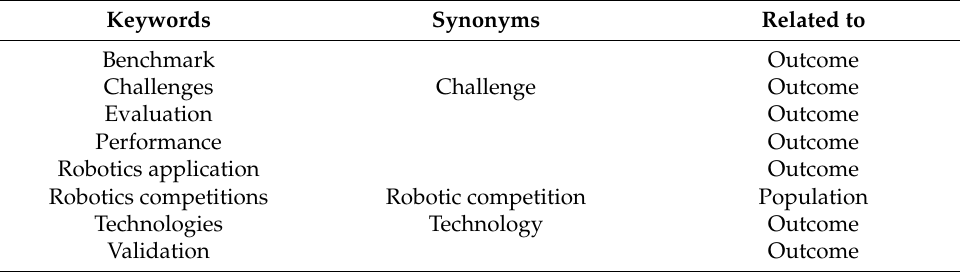
Table 1. Keywords and synonyms chosen for the